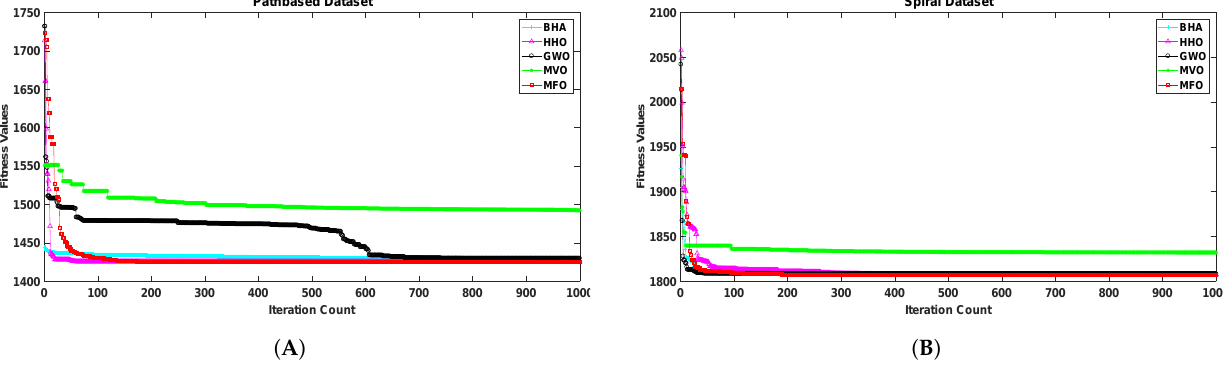
Figure 4. Variation in the best fitness values of algorithms for datasets ( A ): Pathbased, ( B ): Spiral with respect to